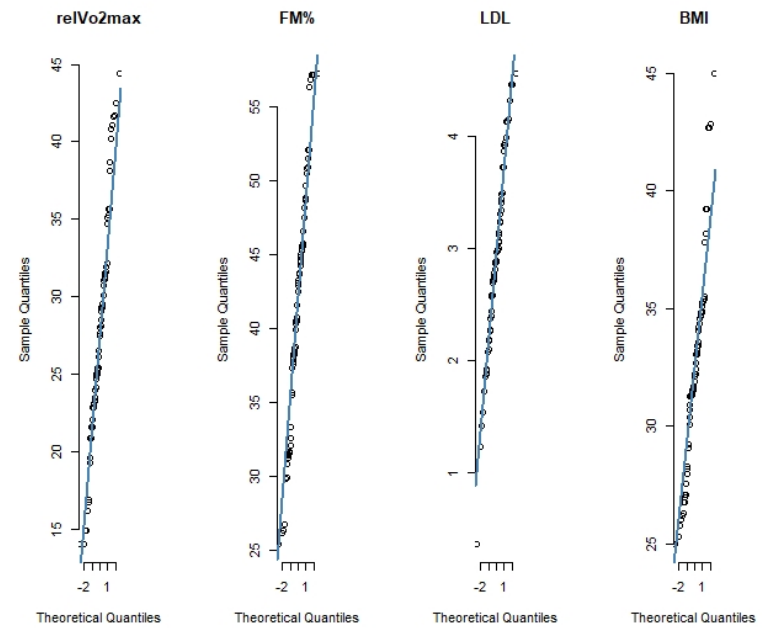
Figure 6. Quantile–quantile plots of the variables that showed partial Figure 6. quantile–quantile plots of the variables that showed partial mediation.